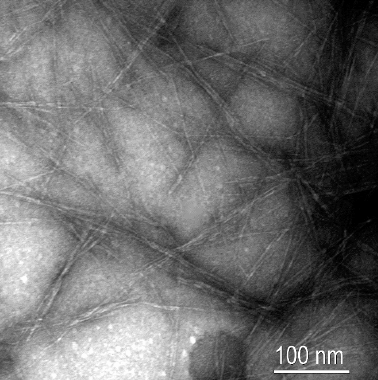
Figure 1. Transmission electron microscopy (TEM) image of the obtained cellulose nanofibers (CNF).